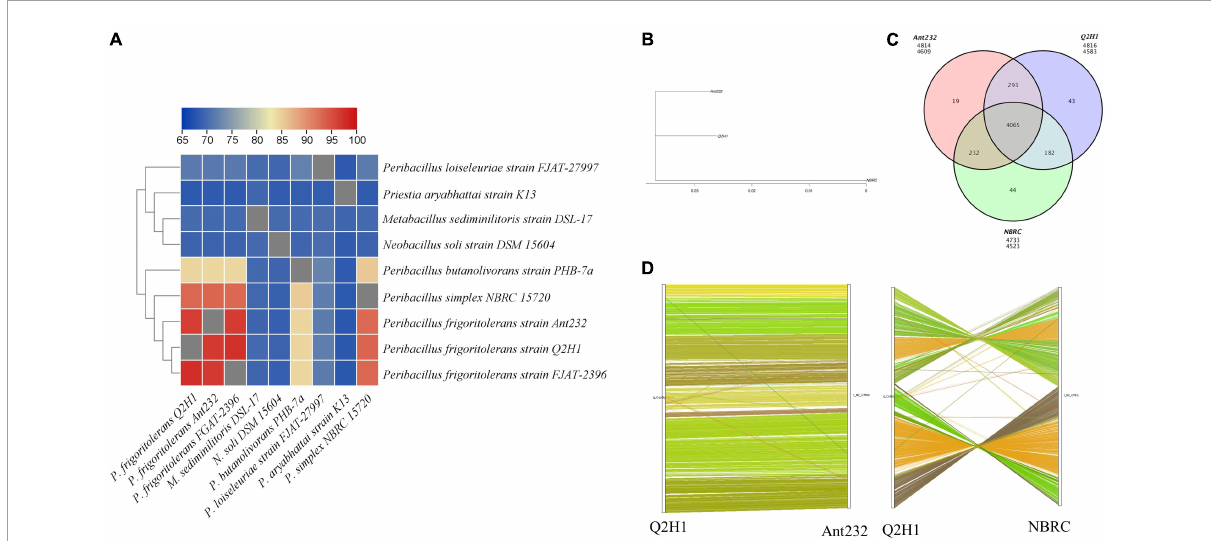
FIGURE3 Comparative genomics analysis of Q2H1 strain: (A) Heat maps of average nucleotide identity (ANI) between strain Q2H1 and phylogenetically eight closely related species. (B) Evolutionary relationship between Q2H1 and two species. (C) Venn diagram of gene family statistics. (D) Genome collinearity of Q2H1/Ant232 and